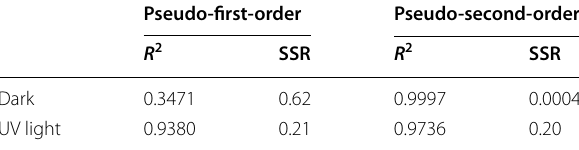
Table 1 Kinetic correlation coefficients ( R 2 ) fitting